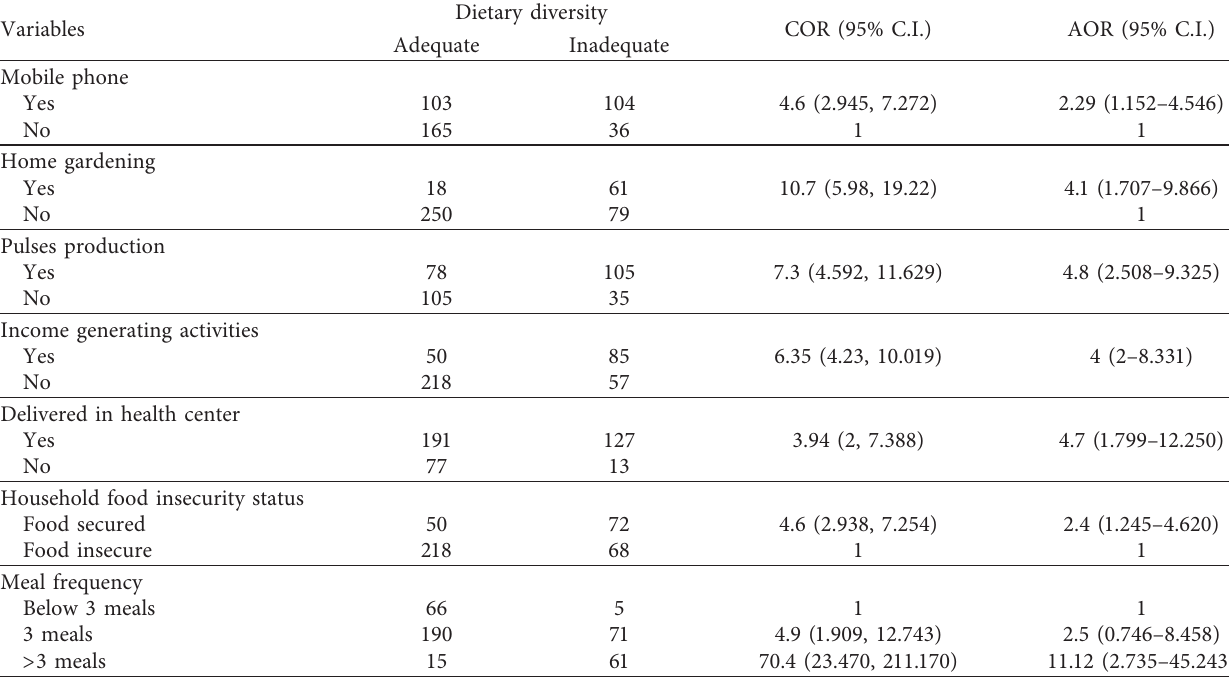
Table 4: Bivariable and multivariable associations of factors with dietary diversity among lactating mothers in Lay Gayint District, South Gondar Zone, Ethiopia, March 2018. Dietary Variables